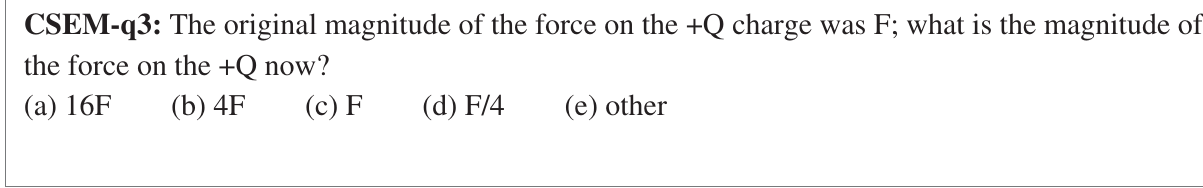
b for the seven almost identical items in the two CIs. In Fig. 10, two identical items in the two CIs are used to illustrate the potential difference.